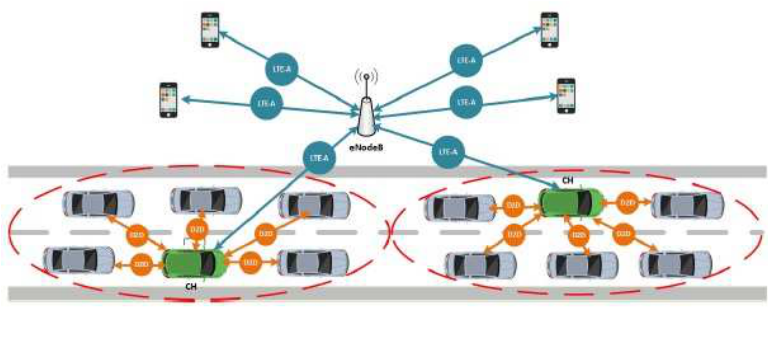
Figure 1. Scenario